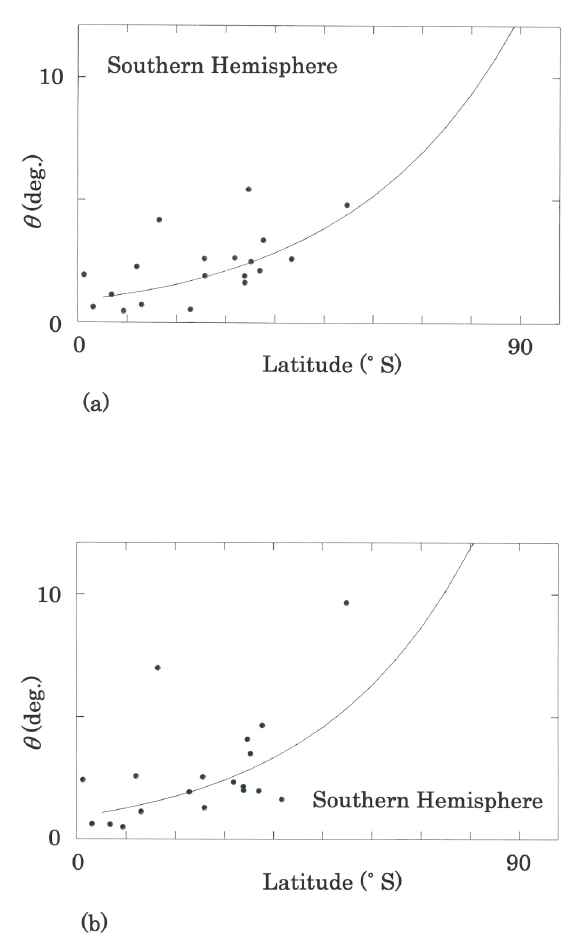
Figure 3. Rotation angles between the monthly distributions of temperatures on the 19 Southern ‐ Hemispheric stations versus their latitudes. (a) Rotation from Period I (1931 ‐ 1960) to Period II (1951 ‐ 1980) is calculated. The curve in the plots represents the optimal exponential regression ( r = 0.605 with 4 ‐ d = 1.172 > d U = 1.13 for n = 19). (b) Rotation from Period II (1951 ‐ 1980) to Period III (1981 ‐ 2010). The curve in the plots represents the optimal exponential regression ( r = 0.598 with 4 ‐ d = 1.787 > d U = 1.13 for n = 19).